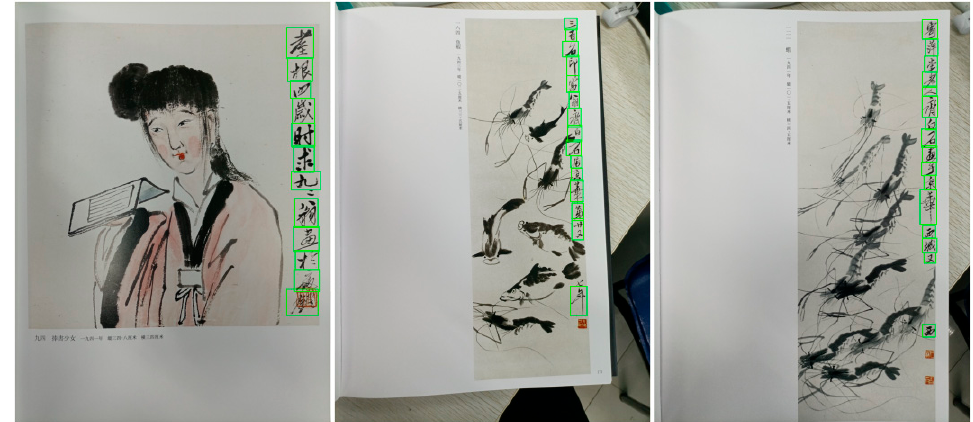
Figure 11. Detection results.